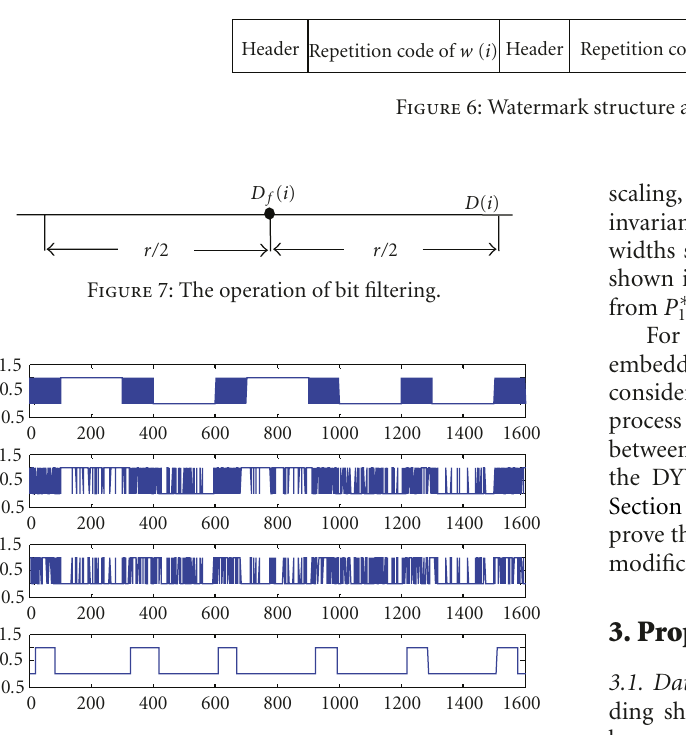
Figure 8: The 1st to 4th figures are w 1 , w ∗ 1 , D , and D f ,